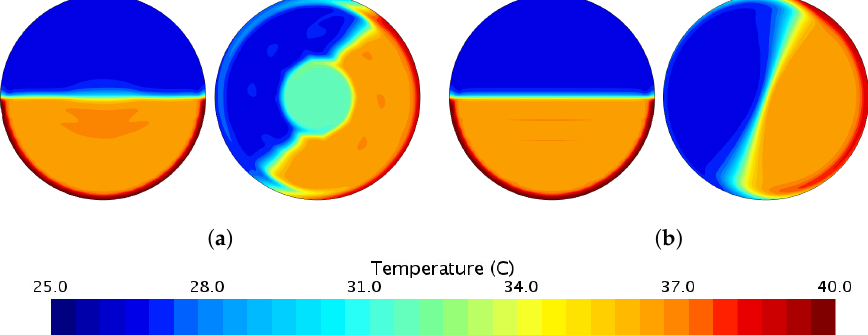
Figure 6. Temperature field up- and downstream of the fan region at a rotational speed of 1400rpm obtained by an MRF simulation. Panels ( a ) and ( b ) at ˙ m = 1kg/s with ( a ) and without ( b ) blades. ( a ) MRF with blades; ( b ) MRF without